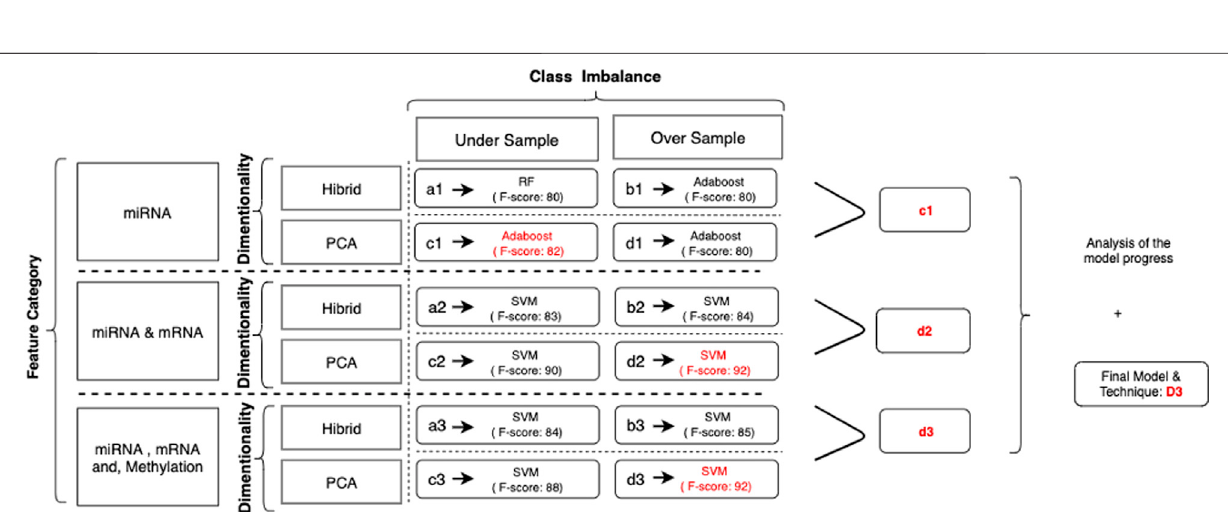
Frontiers in Molecular Biosciences |